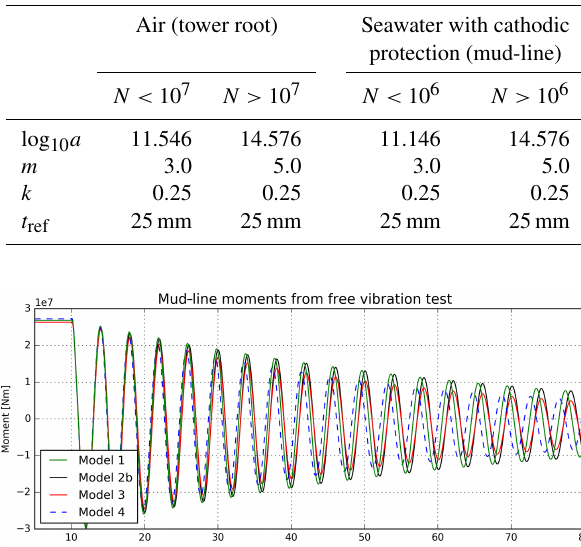
Table 3. S - N curve parameters.